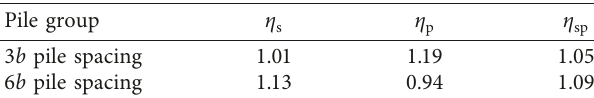
Figure 16: The pile shaft resistance-settlement curves. (a) 3 b pile spacing. (b) 6 b pile Table 3: Comparison of group efficiency.